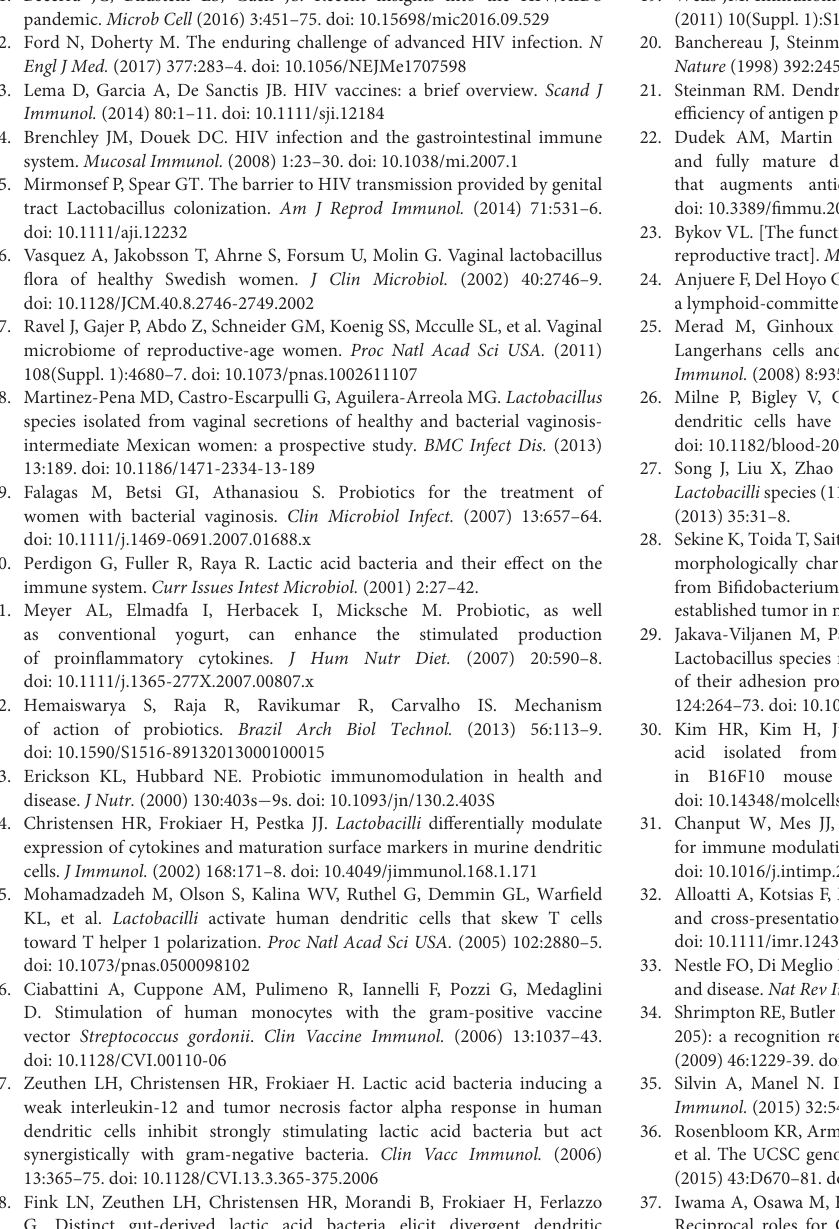
fluorescence intensity) compared to CD80 and corresponding isotype controls. Figure S2 | TEM images of THP-1 treated with L. crispatus and L. fermentum . No Birbeck granules were observed in THP-1 cells stimulated with L. crispatus and L. fermentum . Table S1 | Identification of vaginal lactobacilli uses different methods. A 16s rDNA clone, the API 50 CH System and Bergey’s Manual of Systematic Bacteriology were used to identify the vaginal